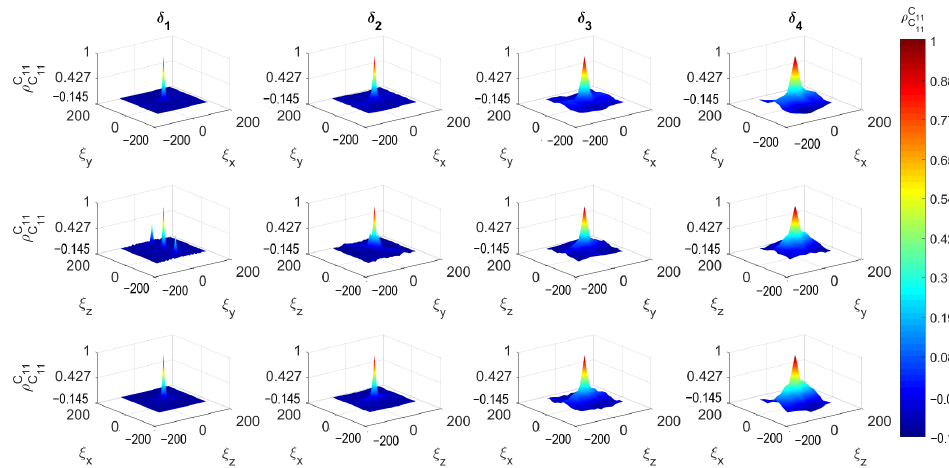
Figure 8. Auto-correlation function of ¯ C 11 .